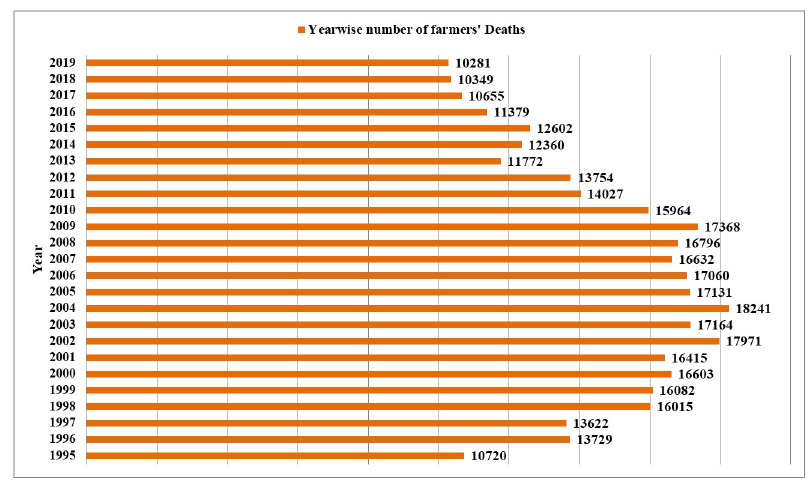
Fig 8. Year-wise numbers of farmers’ suicidal deaths in India during